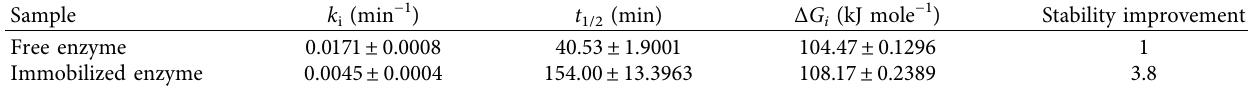
Table 2: k i , Δ G i , and t 1/2 values of the free and immobilized enzymes.